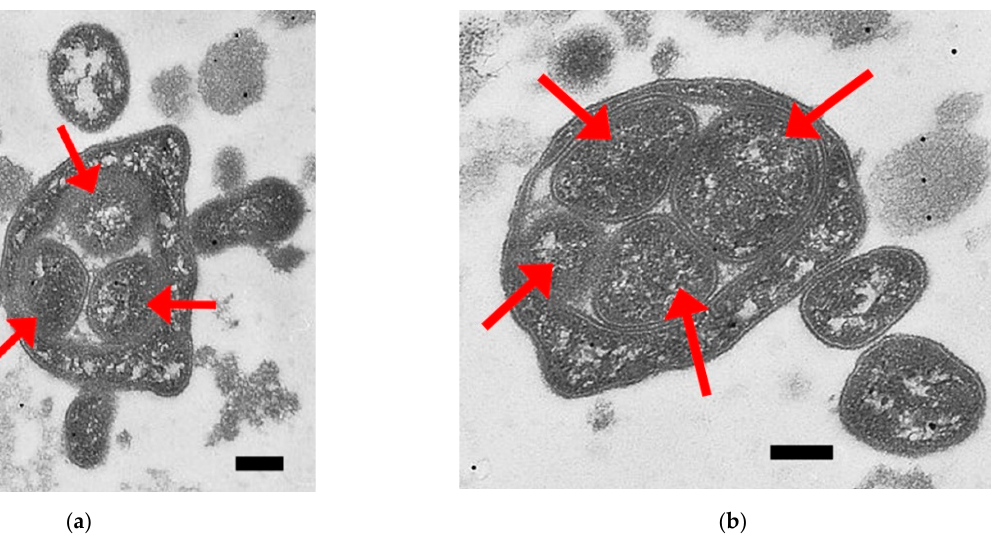
Figure 2. Electron microscopy images of Ureaplasma parvum ser. 3 cells. Red arrows point at the probable cell-in-cell structures of U. parvum ; ( a ) three cells of U. parvum in one huge ureaplasma “cell envelope”; ( b ) four cells of U. parvum in one huge ureaplasma “cell envelope”, and one of them (left) seems to lose its bilayer. Scale bars: 200 nm.